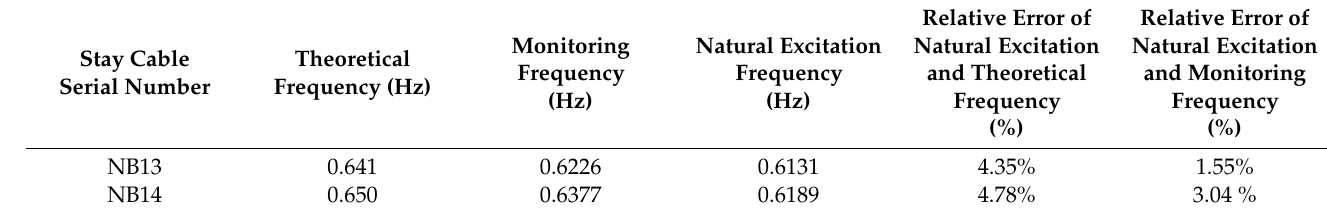
Table 4. Vibration frequency test results of stay